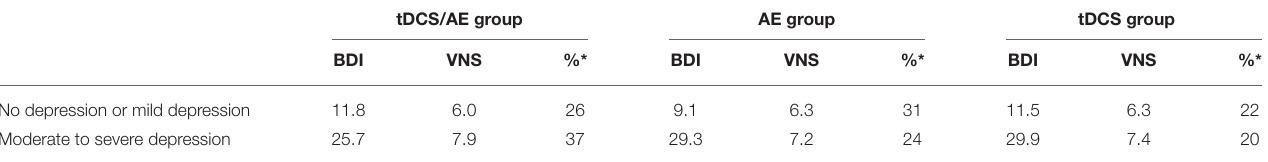
*Percentage of improvement from the mean values. BDI, Beck depression inventory. VNS, Visual numeric scale.